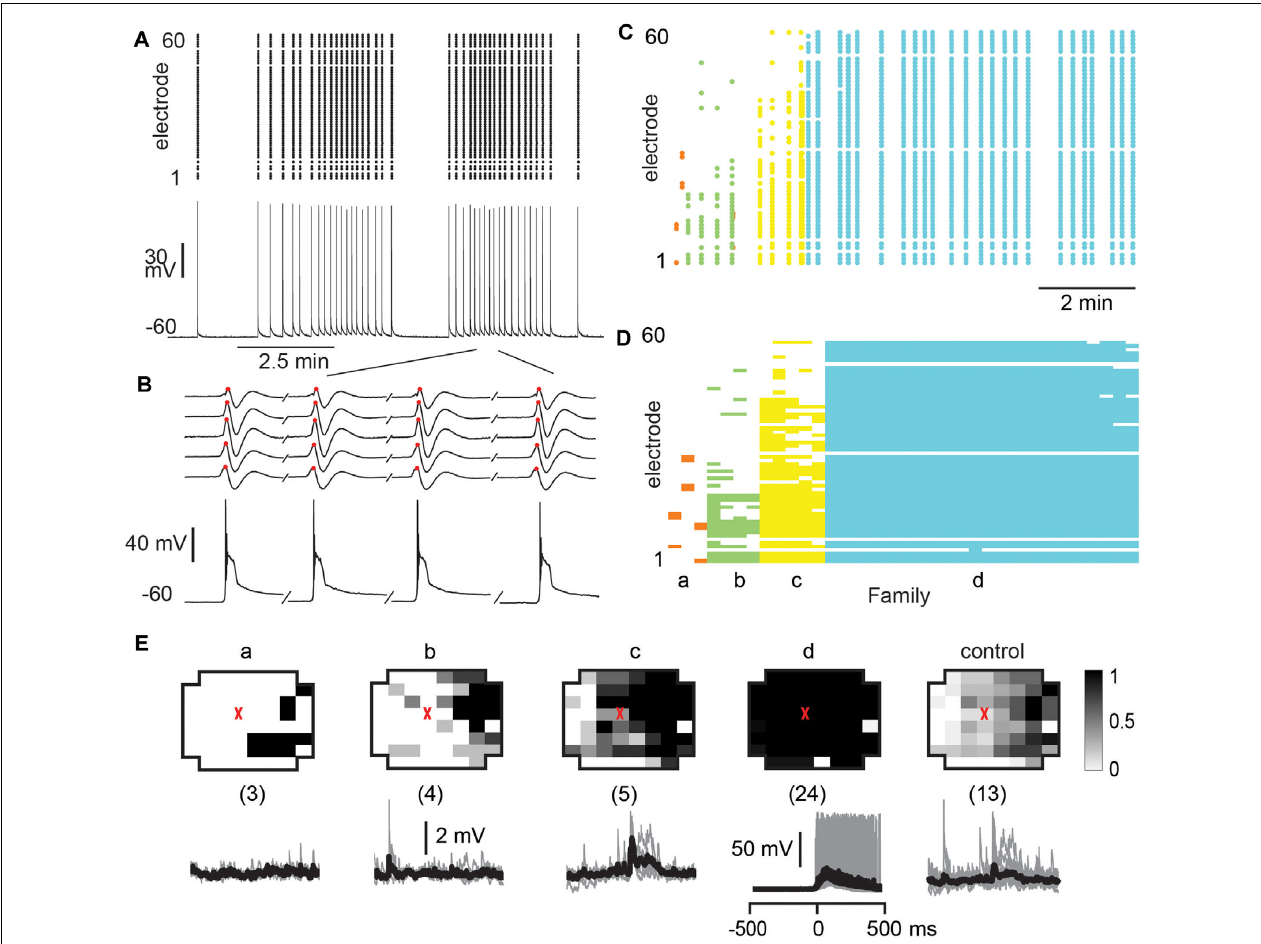
FIGURE 10 | Global disinhibition reduces family diversity uncovering system-wide synchronization and tightly coupled neuronal firing. (A) Disinhibition induces synchronous nLFP activity on the MEA time-locked with a single neuron firing. PTX (50 µ M) was bath applied at the beginning to block fast GABA A receptor mediated inhibition. Top: nLFP raster. Bottom: intracellular membrane potential of a whole-cell patched pyramidal neuron. (B) Enlarged period in a demonstrating synchronous time course of nLFPs and corresponding large intracellular depolarization with spiking activity. Sequential occurrence of four population events grouped in time (discontinuity indicated by a forward slash). (C) nLFP raster on the MEA with color-coded avalanche families and their temporal occurrences. Note few families and tight firing for system-wide population event, identified as family d . (D) Corresponding family-sorted raster. (E) Most population events belong to family d , which spans most recording sites and always caused the patched cell to fire, i.e., the patched neuron was unselectively involved in network dynamics. Top: average patterns for each family. The red triangle marks the soma location of the patched neuron. The numbers of trigger events are shown in parentheses. Bottom: family-triggered average membrane potential waveforms ( black ). Pre-averaged individual traces are shown in gray. Vertical scale bars—2 mV (families a , b , and c ), 50 mV (family d ).